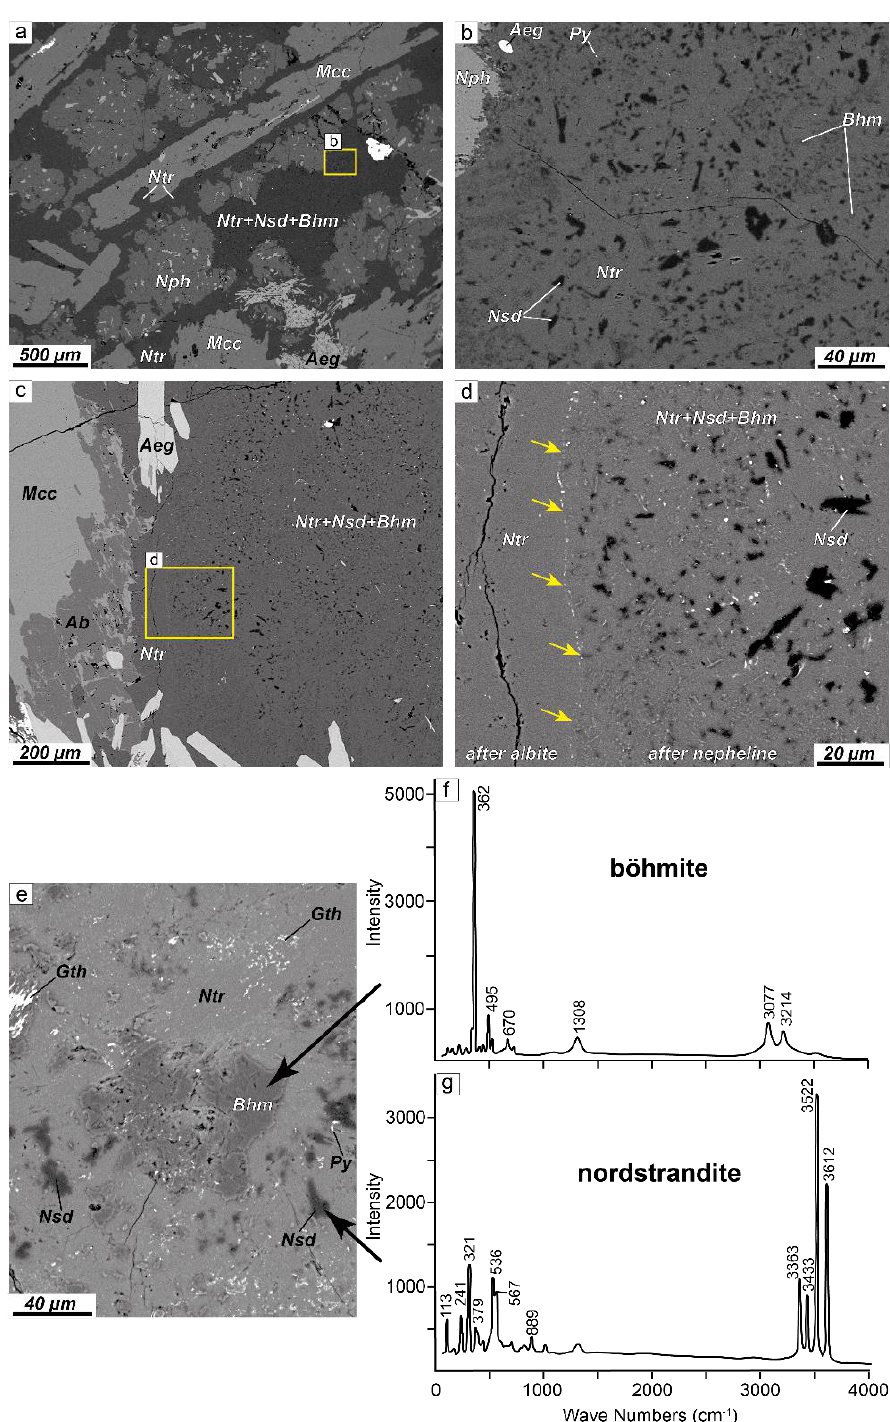
Figure 4. Secondary alteration of nepheline and albite in foyaite from the Layered complex. ( a ) Replacement of nepheline by an aggregate of natrolite, nordstrandite, and böhmite; BSE image; ( b ) detailed BSE image of Figure 4a; ( c ) albite is replaced by natrolite (left), while nepheline is replaced by the natrolite + nordstrandite + böehmite association (right); BSE image; ( d ) detailed BSE image of Figure 4c; yellow arrows mark the boundary between natrolite replacing albite and the natrolite + nordstrandite + böehmite association replacing nepheline; ( e ) association of secondary minerals replacing nepheline; BSE image; ( f ) and ( g ) Raman spectra of böhmite and nordstrandite, respectively. Sample LV-335/4.